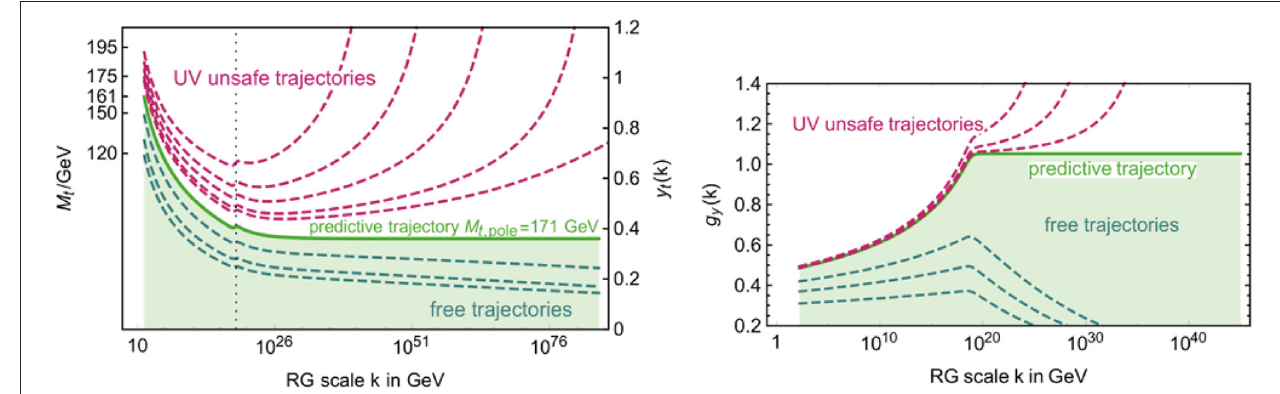
FIGURE 12 | From Eichhorn and Held (2018) and Eichhorn and Versteegen (2018). Based on the beta functions (Equations 56, 58) with f g > 0 and f y > 0, respectively, an IR attractive fixed point results in a unique trajectory and serves as an upper bound.